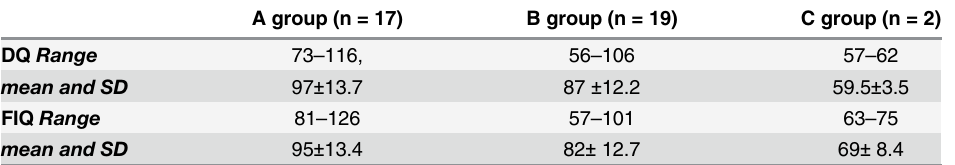
Table 3. DQ and FSIQ range, mean and SD in A, B, C group. A group : Patients with mutations upstream exon 44 (n 17), B group : Patients with mutations in exon 44 – 55 predicted to affect Dp140 (n19), C group : Patients with mutations downstream of exon 62, known to affect all the brain isoforms of dystrophin, including the lower molecular weight Dp71 isoform (n =